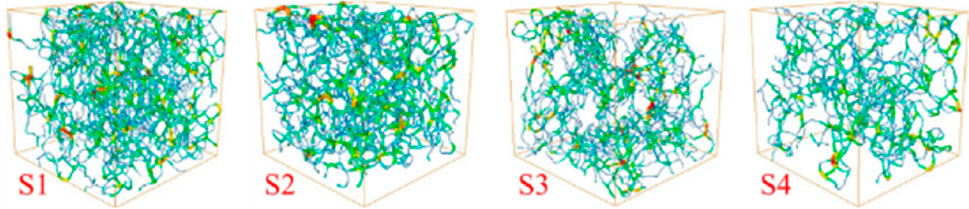
Figure 10. Model of porous seepage channel: Connected pore models of samples S1, S2, S3 and S4 in Figure.